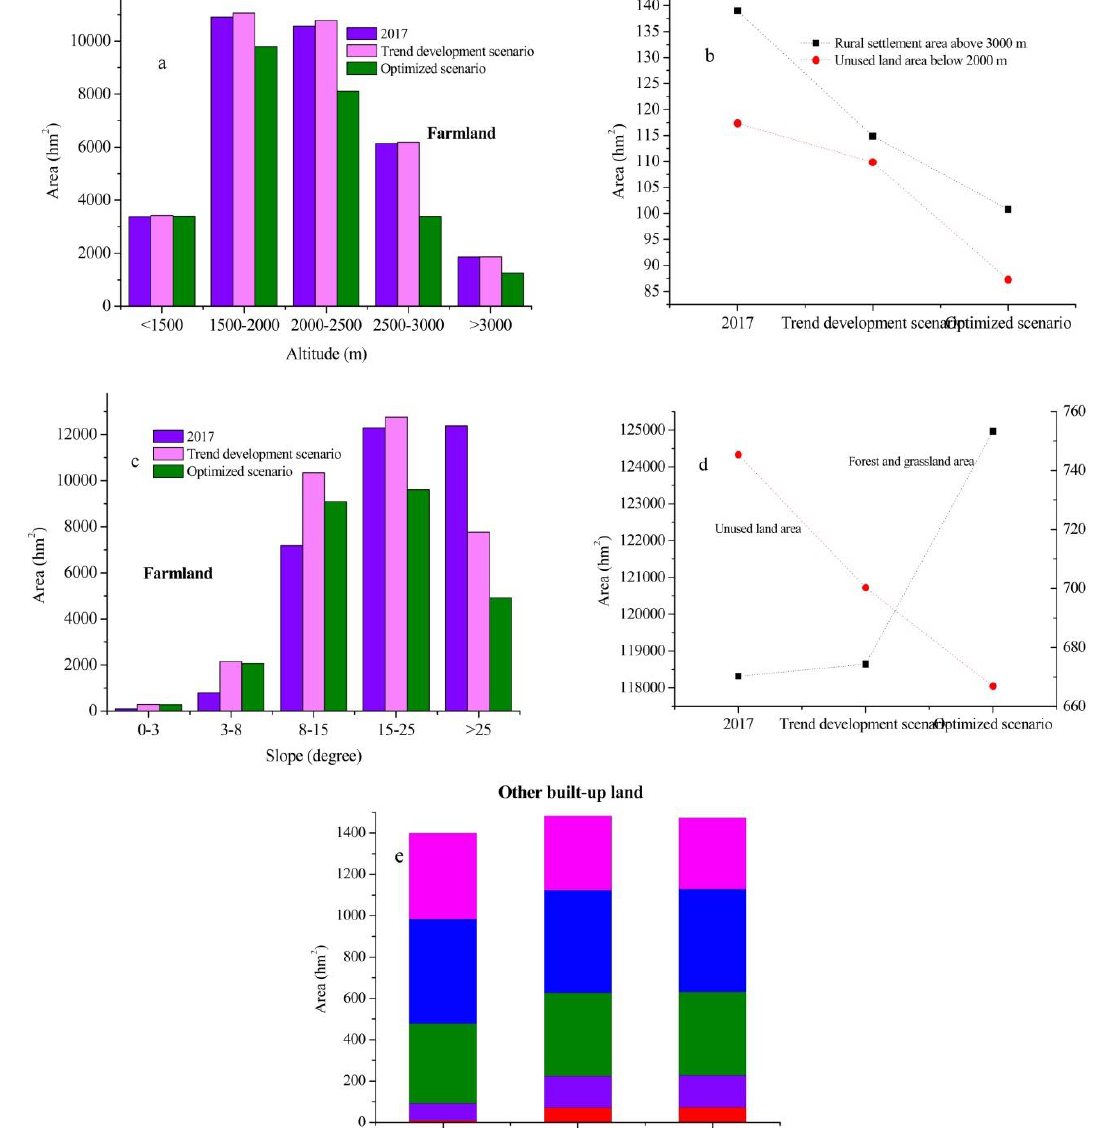
Figure 12. Comparison of area of land use under different scenarios (hm 2 ). (a) The area of farmland on different altitudes; (b) the areas of rural settlement above 3000 m and unused land below 2000 m; (c) the areas of farmland on different slopes; (d) the area of forest, grassland and unused land on slopes above 15°; (e) the area of other built-up land on different relief amplitude.